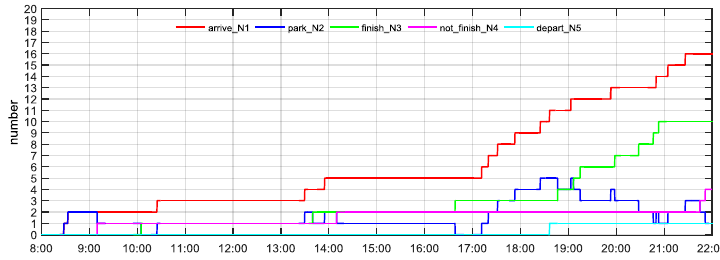
Figure 33. Recording of EV charging under SPVA.